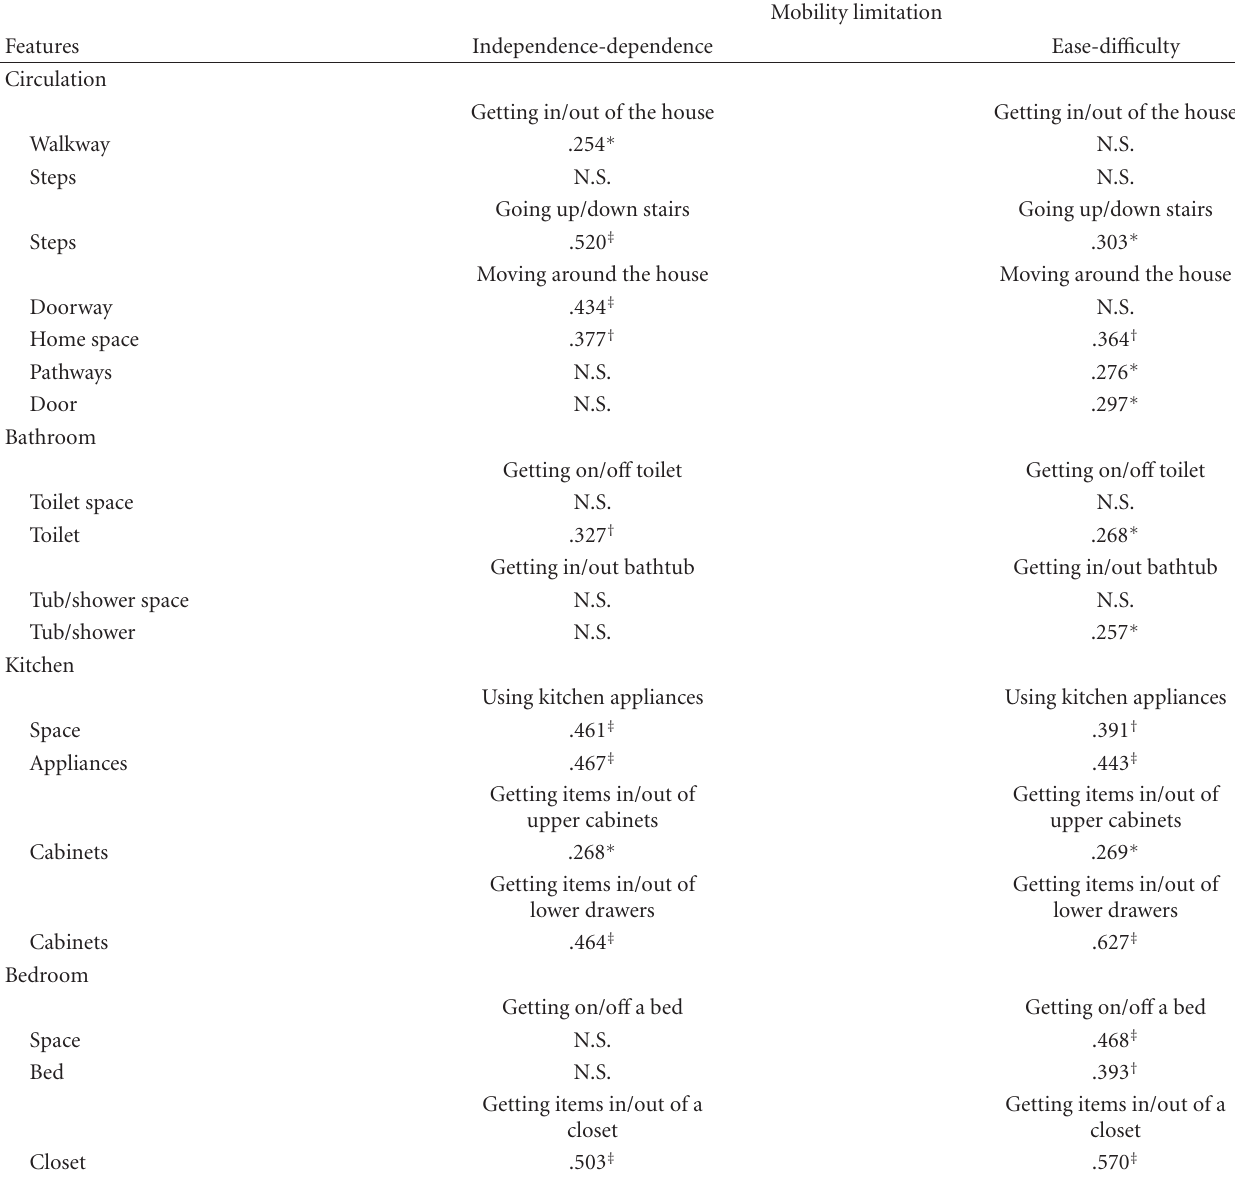
Table 5: Correlations between environmental features and (1) activity independence-dependence and (2) activity ease-di ffi